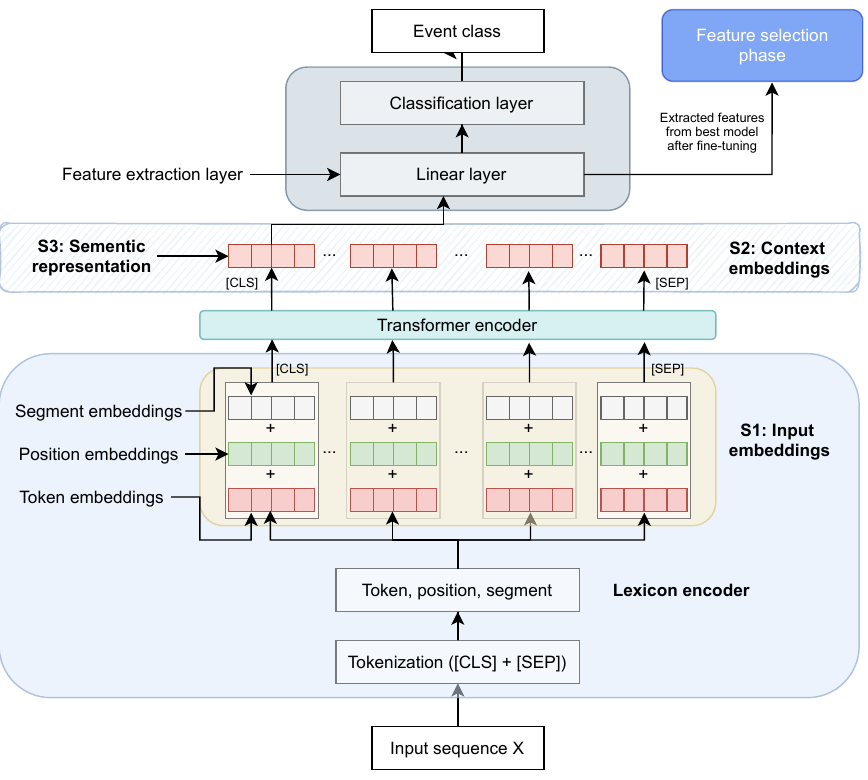
Figure 1. The proposed feature extraction